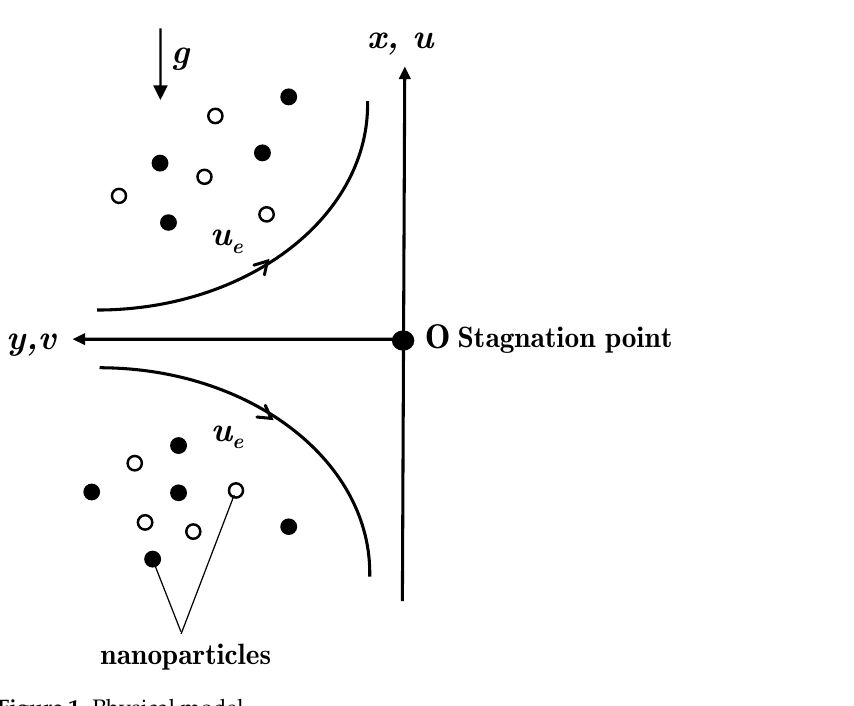
Figure 1. Physical Figure 1. Physical model.